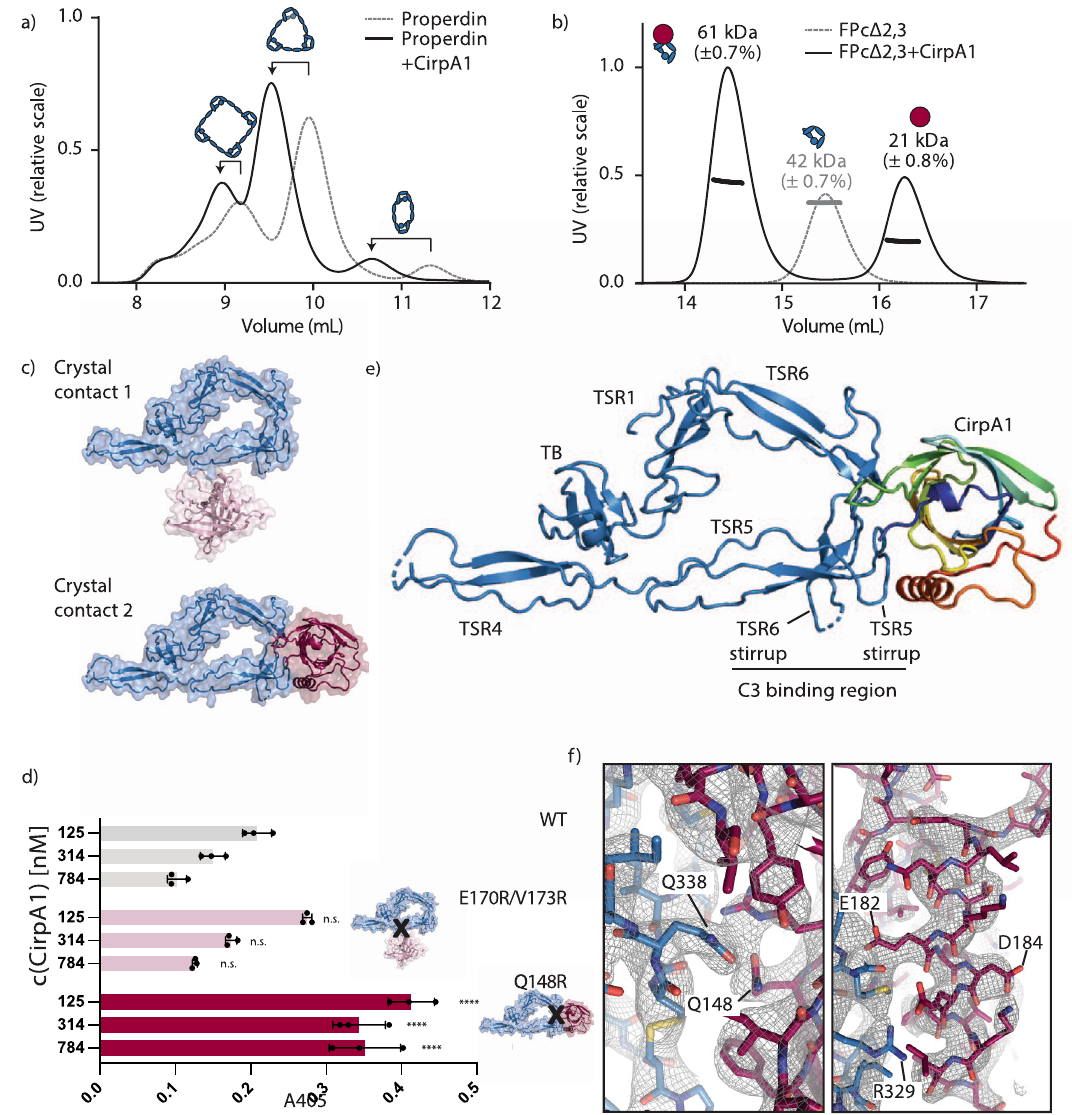
Fig. 3 Analysis of the CirpA1 binding behaviour to human properdin. a Size exclusion chromatography of properdin isolated from human serum with and without pre-bound CirpA1. b SEC-MALS demonstrates binding of CirpA1 to FP Δ 2,3 in a 1:1 stoichiometry. c Crystal contacts observed between CirpA1 and FP Δ 2,3 result in two possible binding sites of CirpA1. d AP haemolysis assay with serum from Homo sapiens (human), WT = wild-type CirpA1, E170RV173R = CirpA1 carrying point mutation in crystal contact 1, Q148R = CirpA1 carrying point mutation in crystal contact 2. n.s = not signi fi cantly different from wild type ( p > 0.001, **** = signi fi cantly different from WT ( p < 0.0001) as assessed by two-way ANOVA. Errors bars are Mean with s.d. from three technical replicates ( n = 3). e Crystal structure of the complex between FP Δ 2,3 (blue) and CirpA1 (rainbow). f Close up of the 2Fo-Fc, ac map in the FP Δ 2,3-CirpA1 interface region (left) and the CirpA1 C-terminal helix. Source Data are provided as a Source Data fi